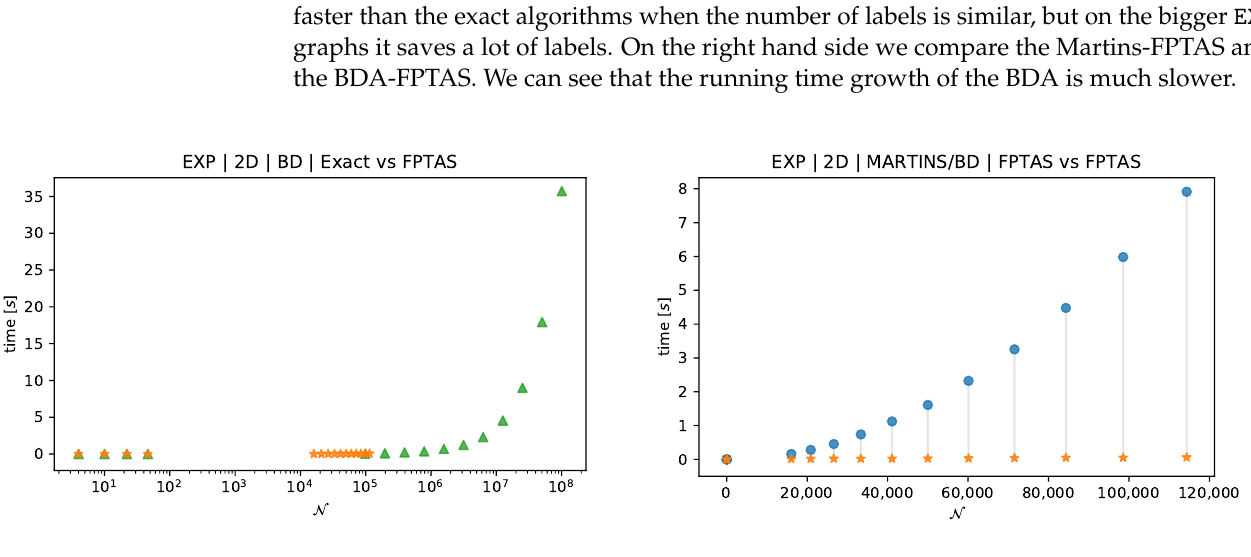
Figure 5. BDA exact (green), BD-FPTAS (yellow) and Martins-FPTAS (blue) on exponential instances. ε =